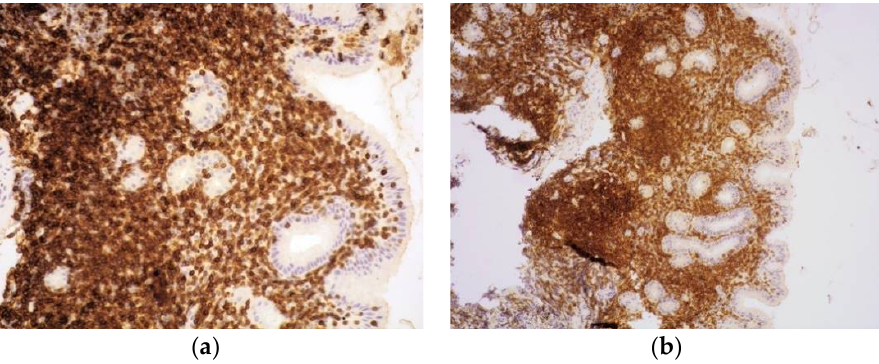
Figure 3. Intense and diffuse expression of T-cell markers CD3 ( a ) and CD4 ( b ). (Haematoxylin and eosin, original magnification 400× and 200×).